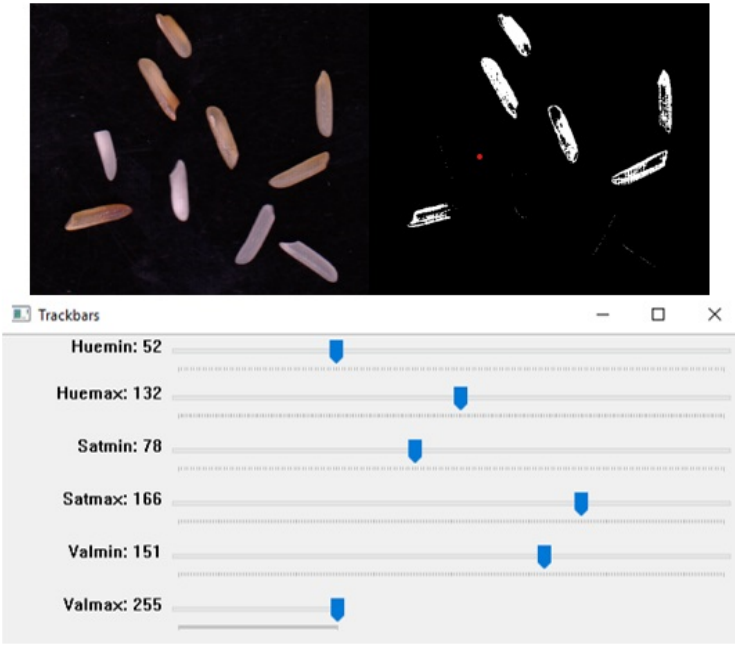
Figure 8. The image shows rice images before and after scanning and the ranges of given HSV com- ponents extracting yellow rice from the sample